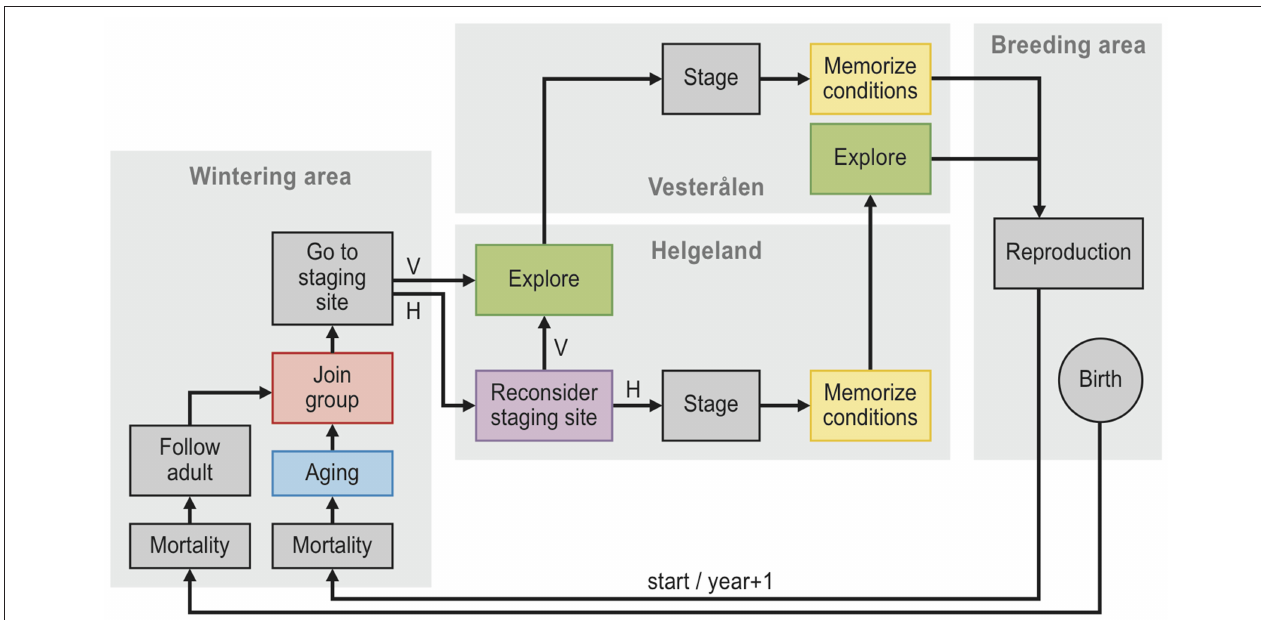
FIGURE 2 | Flow chart diagram of the twelve individual-based models. Schematic overview of the individual-based model simulations. Each simulation begins with 3,000 individuals at start, and each individual follows the arrows in the diagram, with each cycle representing one year. The models, described in Table 2 , differ only in the presence or absence of five components: “memory” (yellow), “reconsider” (purple), “exploration” (green), “groups” (red) and “aging” (blue). Mortality occurs with a probability of 0.11, reproduction occurs with a probability that depends on the conditions of the staging site (grass production as well as the number of geese at the staging site, see Equation 1) that the female has visited, being either Helgeland (H) or Vesterålen